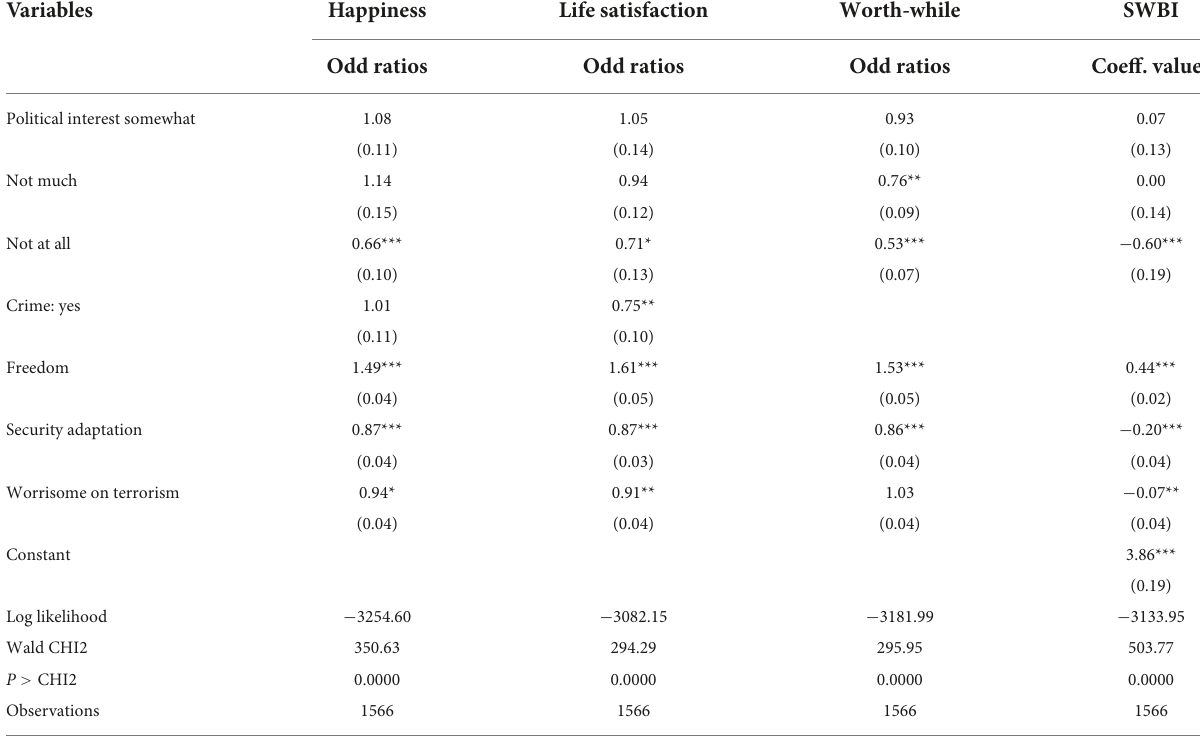
TABLE 7 Perceived factors of individuals as determinants of subjective wellbeing method: Ordered logit model Id. Variables Happiness Life satisfaction Worth-while SWBI Odd ratios Odd ratios Odd ratios Coeff.